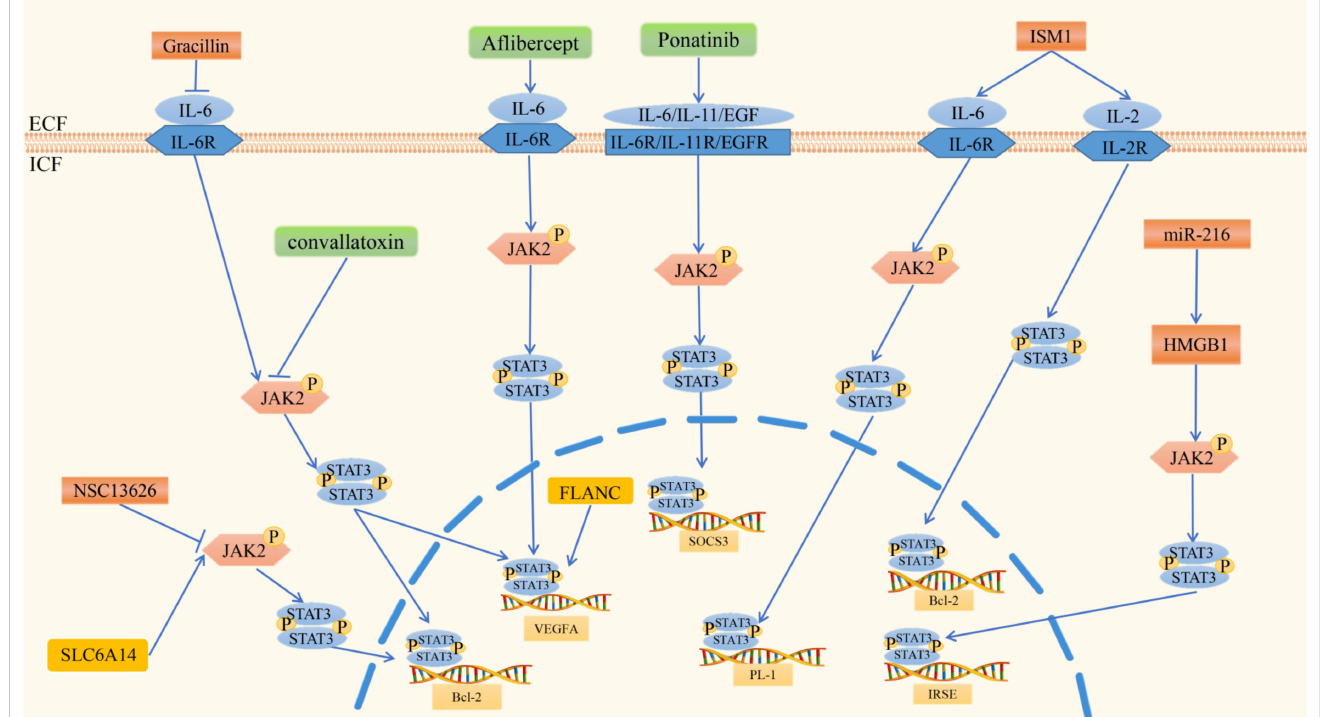
Figure 3. Regulation of angiogenesis via the JAK2/STAT3 signaling pathway in CRC. In the JAK2/STAT3 signaling pathway, SLC6A14 and FLANC promote angiogenesis. SLC6A14 activates JAK2 through phosphorylation, after which STAT3 is activated by mutual phosphorylation, and STAT3 then enters the nucleus and activates the transcription of Bcl-2. FLANC enters the nu- cleus directly and activates the transcription of VEGFA. Factors inhibiting CRC angiogenesis via JAK2/STAT3 signaling include ISM1, NSC13626, Gracillin, and miR-216. ISM1 activates the tran- scription of Bcl-2 via the IL2/STAT5 signaling pathway and activates PL-1 via the IL6/JAK2/STAT3 signaling pathway. NSC13626 has a negative feedback mechanism with JAK2, and the down- stream target of JAK2 is p-STAT3. Gracillin inhibits the transcription of Bcl-2 and VEGFA via the IL6/JAK2/STAT3 signaling pathway. MiR-216 inhibits angiogenesis by targeting HMGB1, which mediates the JAK2/STAT3 pathway. Aflibercept, convallatoxin, and ponatinib are antiangiogenic drugs in CRC. Aflibercept modulates inflammation-related angiogenesis via the IL-6/JAK2/STAT3 axis, ultimately regulating the transcription of VEGFA. CNT also shows efficacy in the inhibition of JAK2/STAT3 to inhibit the expression of Bcl-2 and VEGFA. Ponatinib inhibits